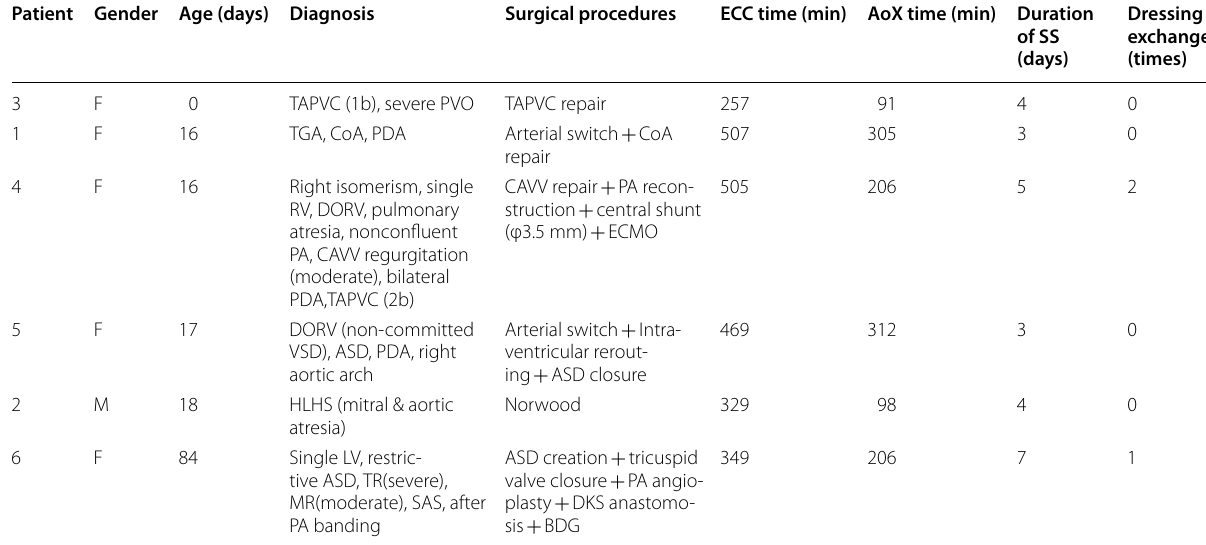
Table 1 Patients’ characteristics